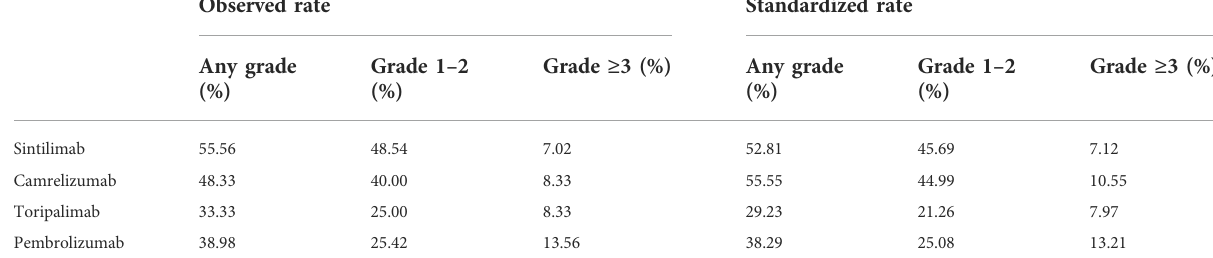
TABLE 2 irAEs of different